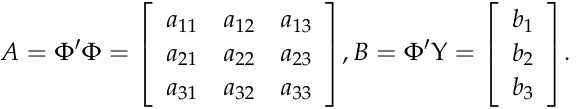
Figure 6. The flow chart of MPDPC control algorithm with Bayesian estimation. 4. Simulation and Experiment Results 4.1. Digital Simulation According to the on ‐ line parameter estimation algorithm proposed in Section 3, the mathematic simulation model of three ‐ phase PWM rectifier is built in Matlab/Simulink (Matlab R2012, MathWorks, Natick, MA, USA). The algorithm of robust MPDPC is written in S ‐ function. The simulation parameters are shown in Table 1.